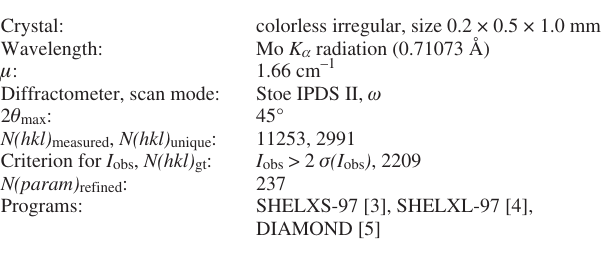
Table 1. Data collection and handling.